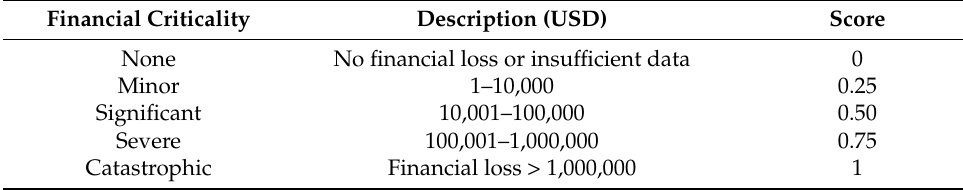
Table 6. Estimation criteria for financial